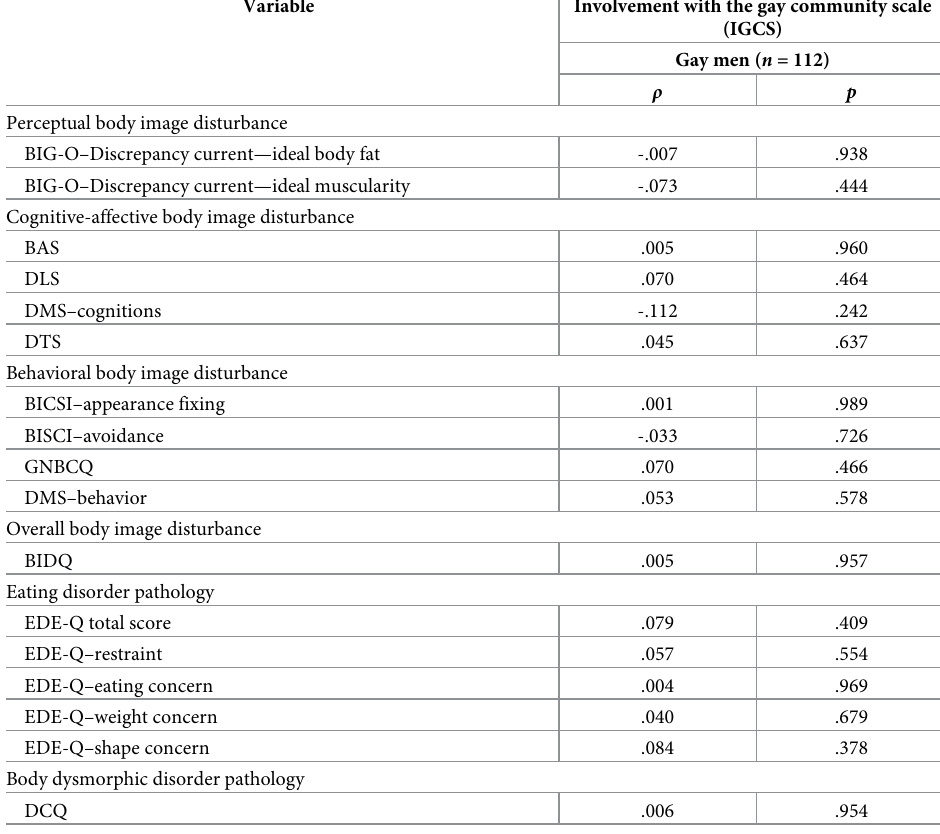
Table 6. Correlations of Involvement with the gay community with body image disturbance facets, eating disor- der pathology and body dysmorphic disorder